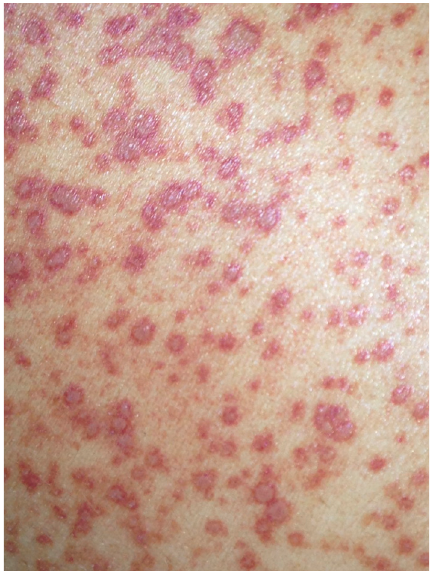
Figure 1: Maculopapular cutaneous lesions on the